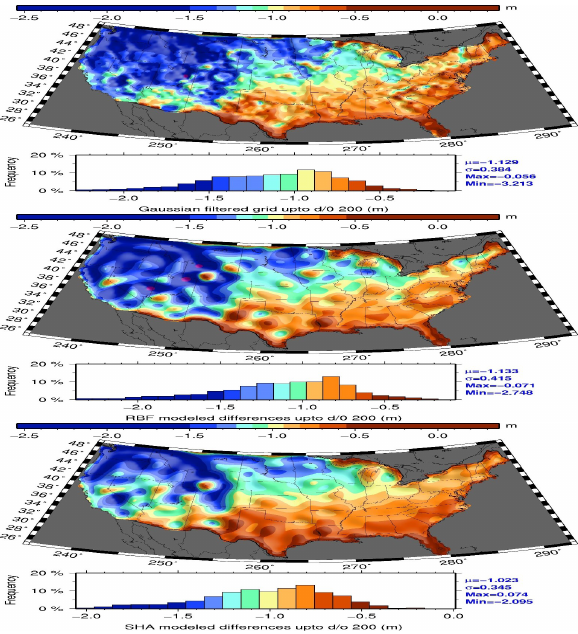
Figure 2: The modeled NAVD 88 differences with respect to GOCO05s up to degree 200 by using different approaches (upper panel Gaussian filter; middle panel RBF; lower panel